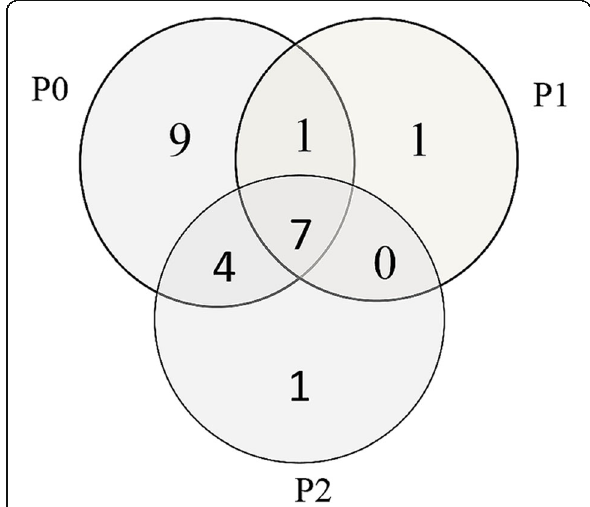
Fig. 2 Prevalence of anti-Rib-P0, anti-Rib-P1, and anti-Rib-P2 antibodies in 53 SLE patients with negative anti-Rib-P ELISA